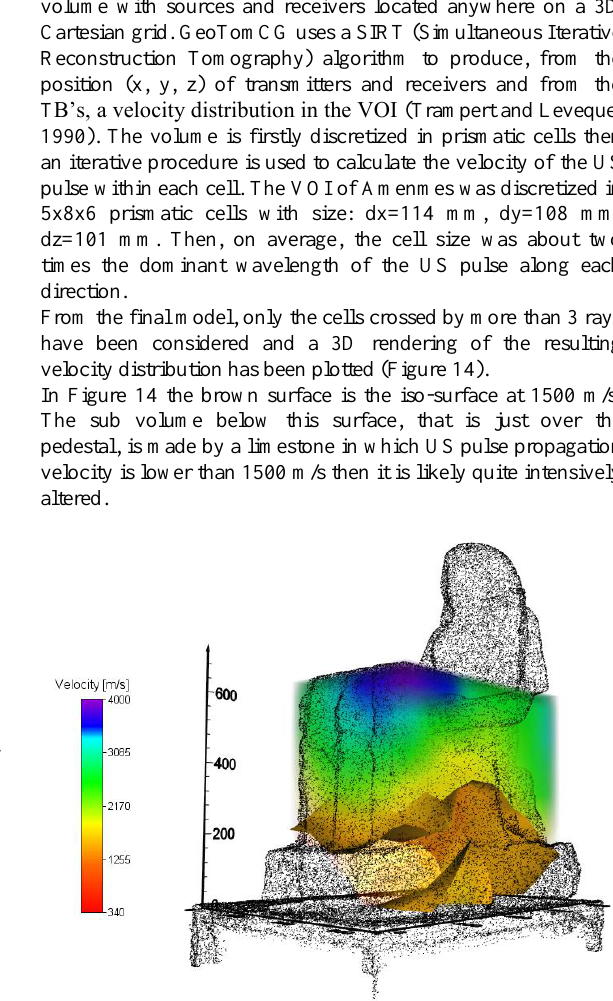
Figure 11. Histogram of the apparent velocities